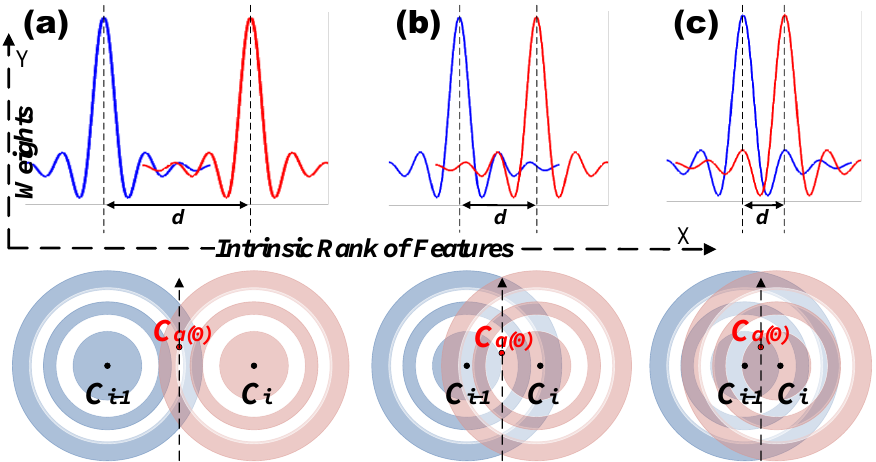
Figure 1. The challenge of ordinal image classification (or scoring). The X-axis denotes the intrinsic rank of features, and the Y-axis denotes the weights of models. C a ( 0 ) is the initial center of the overlapping feature. We assume that the features in ordinal images have an “intrinsic rank”, and the corresponding ordinal category will show a specific concentration in terms of the “intrinsic rank”. C i and C i − 1 are, respectively, the centers of their corresponding neighboring ordinal classes. ( a ) If the distance d between two centers is remote, the “intrinsic rank” is slack. ( b ) If the distance d between two centers is approaching the boundary, the “intrinsic rank” is tight. ( c ) If the distance d between two centers is beyond the boundary, the “intrinsic rank” seems to become a whole part. Under this condition, the classification task would become extremely